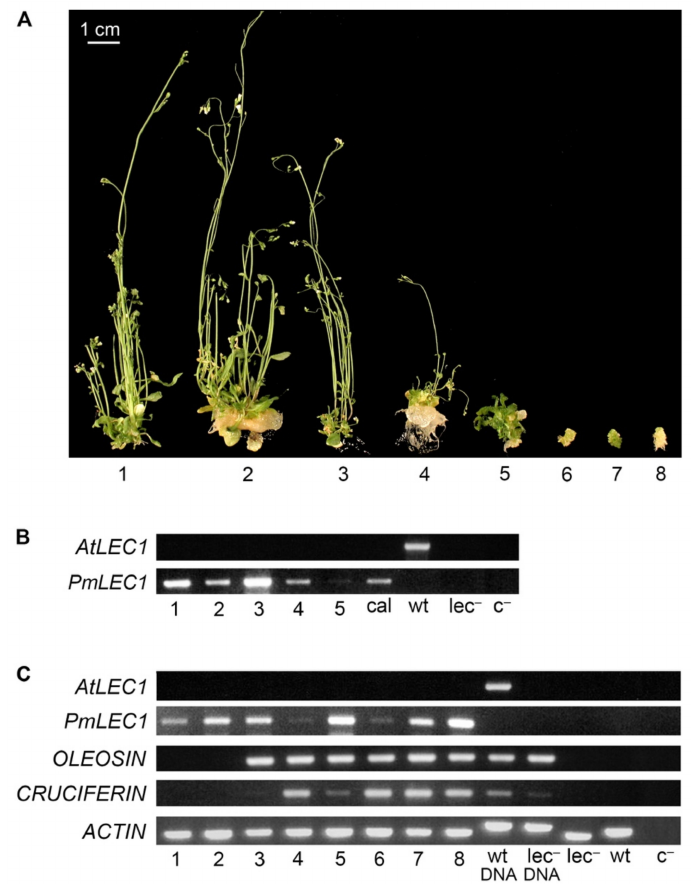
Figure 4. Morphology, genotype analysis and gene expression profiles of individual T2 variants derived from one lec1-1 PmLEC1 T1 progenitor line. ( A ) Morphological variations among T2 seedlings derived from a self-pollinated lec1-1 PmLEC1 T1 transgenic line. ( B ) PCR analysis of T2 variants using AtLEC1 - and PmLEC1 -specific primers (top and bottom panel, respectively) to confirm genotype and the presence of transgenes. Lanes 1 to 5 represent DNA from the plants shown in panel A; cal, DNA from callus tissues morphologically similar to variants 6, 7 and 8 in panel A; wt, genomic DNA from a wild type Arabidopsis plant (positive control); lec − , genomic DNA from a lec1-1 null mutant plant; c − , PCR without DNA template (negative control). ( C ) RT-PCR analysis of gene expression. Each reaction comprised 0.1 µ g DNase I-treated total RNA isolated from the indicated plant material. Analyzed genes are shown on the right of the corresponding panels. Lanes 1 to 8 represent transcripts from the plants shown in panel A; wt DNA, genomic DNA from a wild type Arabidopsis plant (DNA control); lec − DNA, genomic DNA from a lec1-1 null mutant plant (DNA control); lec − , RNA from a lec1-1 null mutant plant; wt, RNA from a wild type Arabidopsis plant; c − , reverse transcription without RNA, followed by PCR (negative